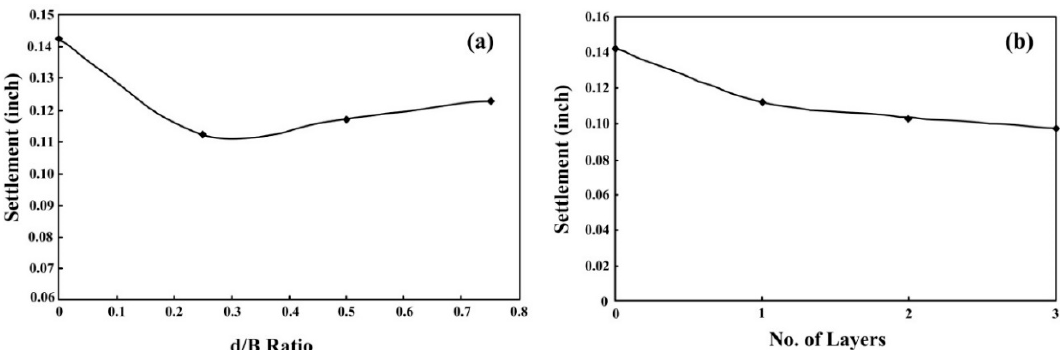
Figure 9. Settlement (inch) variation against ( a ) the d/B ratio of the single-layer system and ( b ) the number of reinforcing layers (modified from Asaduzzaman and Islam [32]).